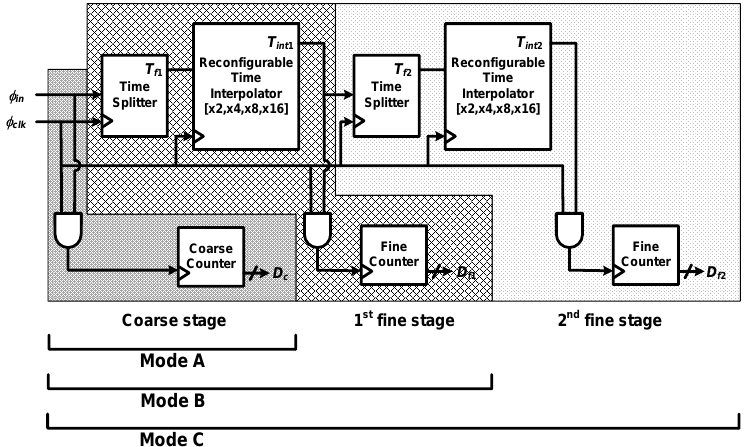
Figure 3. Block diagram of the proposed TDC (reproduced from [18] with permission from the IEEE).